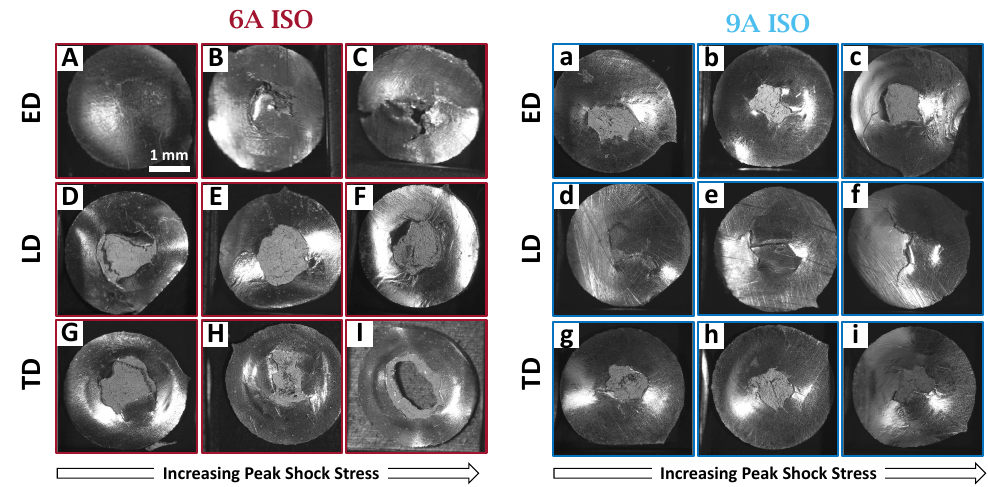
Figure A3. Macroscopic optical post-mortem images for ISO sample sets. Each 3 × 3 grid of images shows characteristic macroscopic damage morphologies for ( A – I ) 6A ISO and ( a – i ) 9A ISO. Each row shows the results for a specific impact orientation: ( top ) ED, ( middle ) LD, and ( bottom ) TD. The peak shock stress within each column is nominally identical and increases from left to right from low to mid to high based on the range shown in Figure A2.